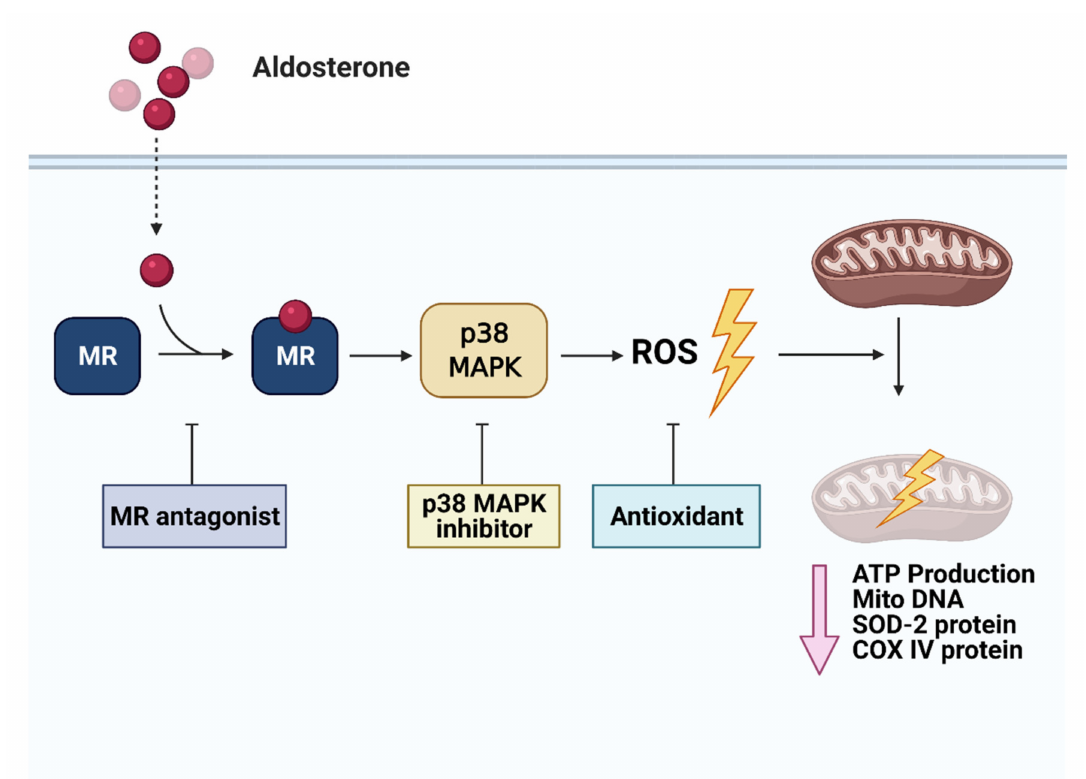
Figure 5. Schematic of the signaling of aldosterone-induced cardiac mitochondrial dysfunction in H9c2 cells. Aldosterone- induced cardiac mitochondrial dysfunction through MR/MAPK/p38 and ROS pathways. Mitochondrial DNA, SOD2, COX IV protein and ATP production were